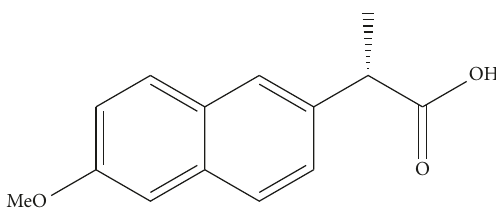
Figure 1: Chemical structure of S-naproxen.